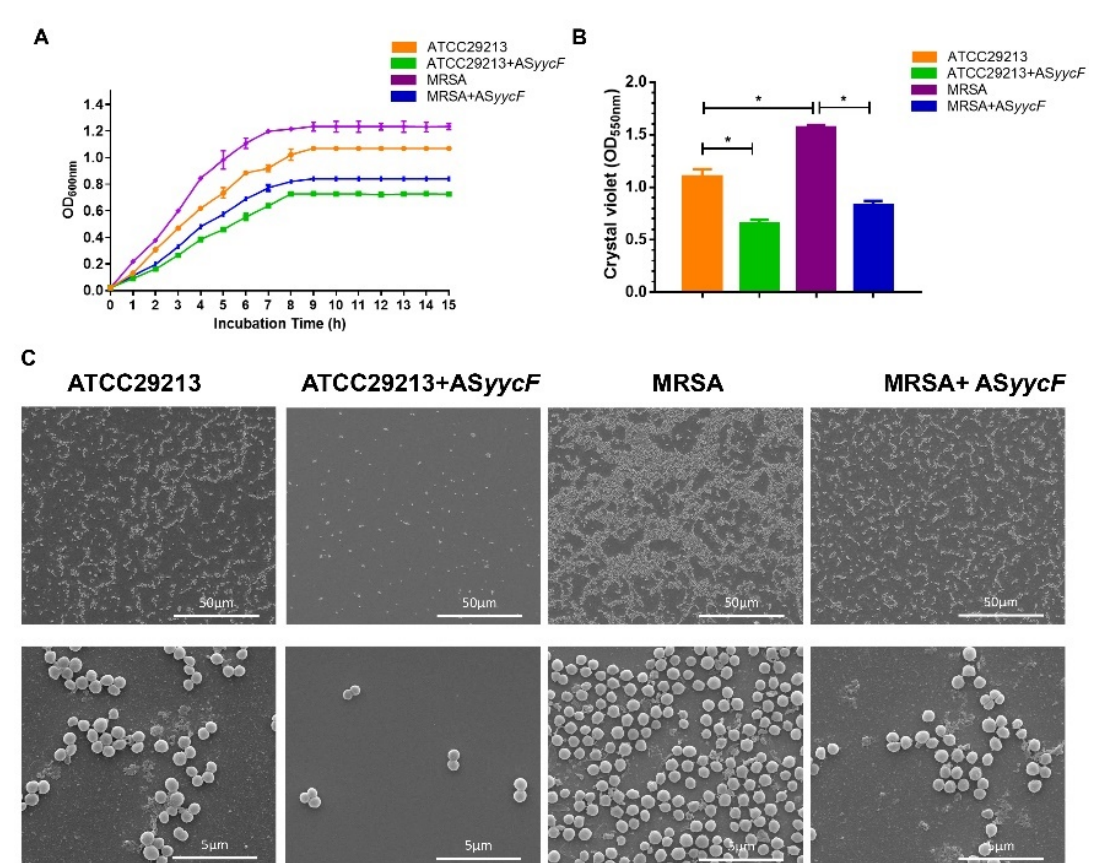
Figure 2. AS yycF modulated the bacterial growth and biofilm organization. ( A ) The growth curves for the Staphylococcus aureus . ( B ) Biomass was quantified by crystal violet staining. Optical densities at 600 nm were measured ( n = 10, * p < 0.05). ( C ) SEM images of S. aureus ATCC29213, and methicillin-resistant Staphylococcus aureus (MRSA) strains after AS yycF